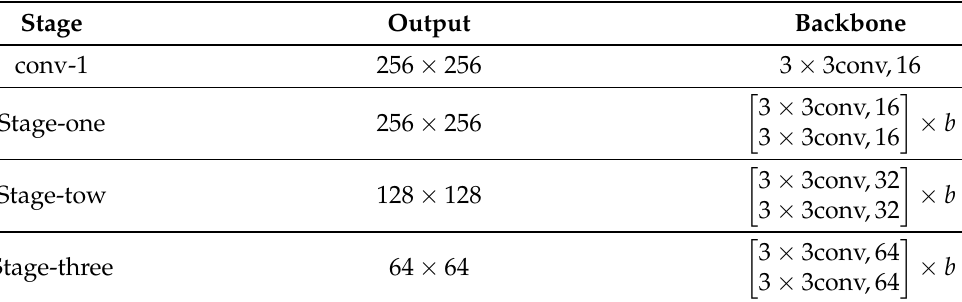
Figure 1. Overall structure of the MDFENet network. Table 1. MDFENet